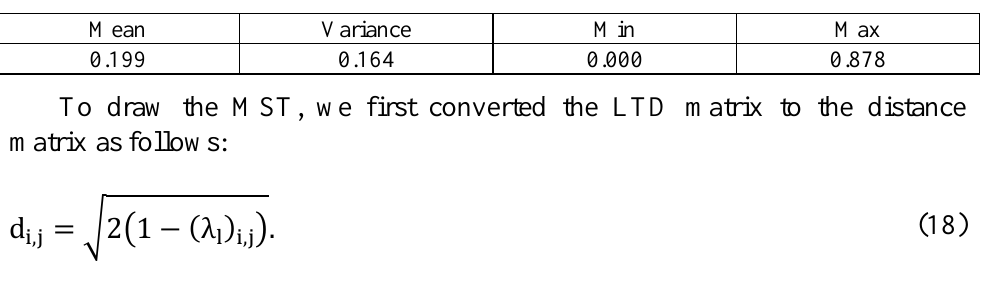
Table 1. LTD statistics of